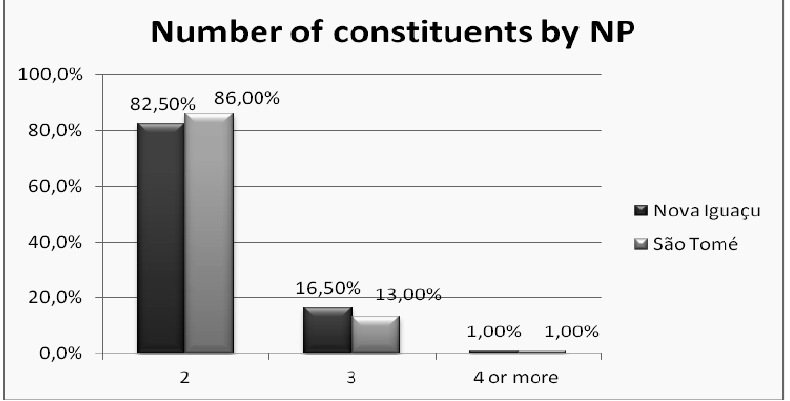
Figure 1. Number of constituents by NP in NIG and ST(2)